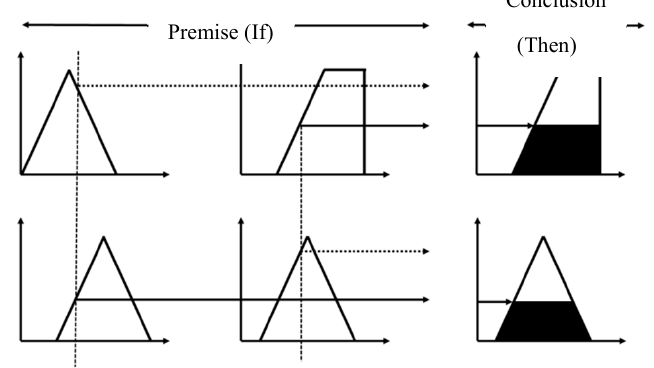
Figure 9. The minimum inference method.